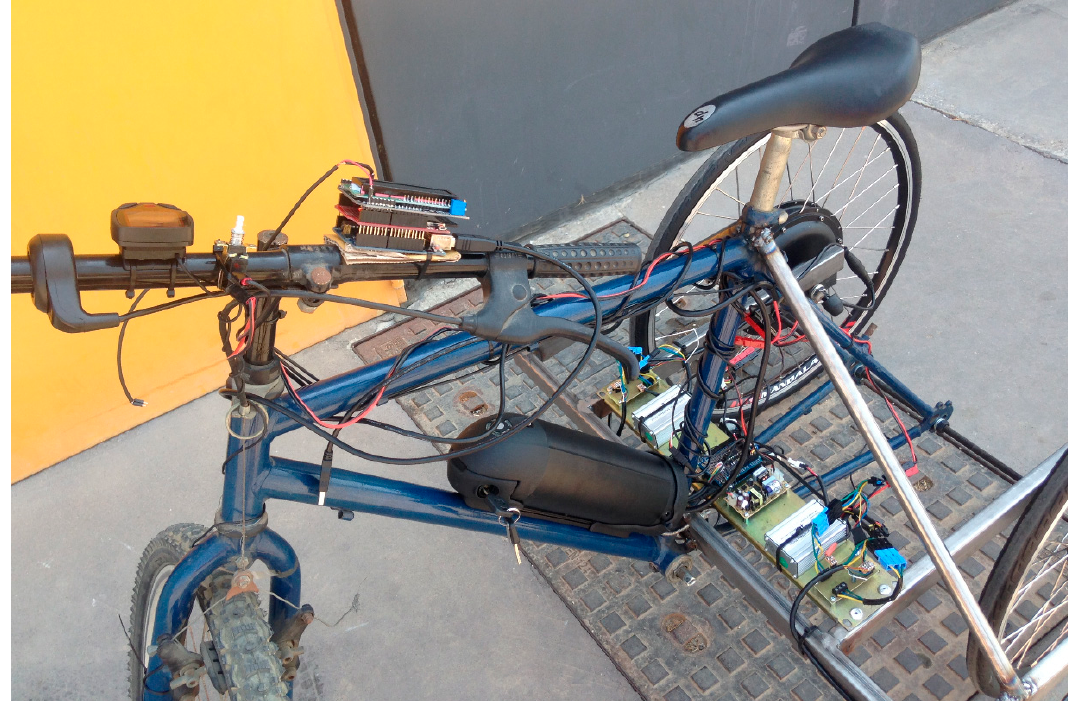
Figure 2. Three-wheel light electric vehicle (LEV) system generated reconditioning a common bicycle. Modifications: Two driving rear wheels with motors integrated; ED and power controllers placed in an added back platform and a battery pack placed in the original frame behind the driver.